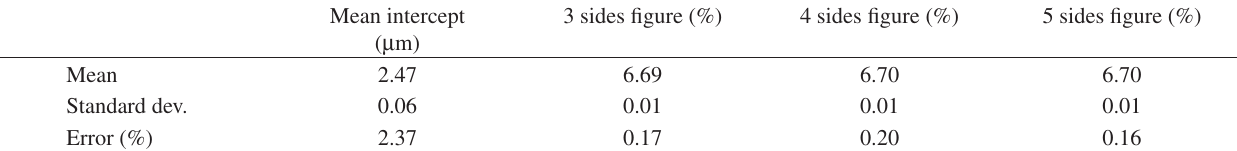
Table 2. Partial and final mean values, deviations and errors in 10 simulations of 1000 prisms of equivalent grain size of 5 (cid:77) m and aspect ratio 1/2. Mean intercept